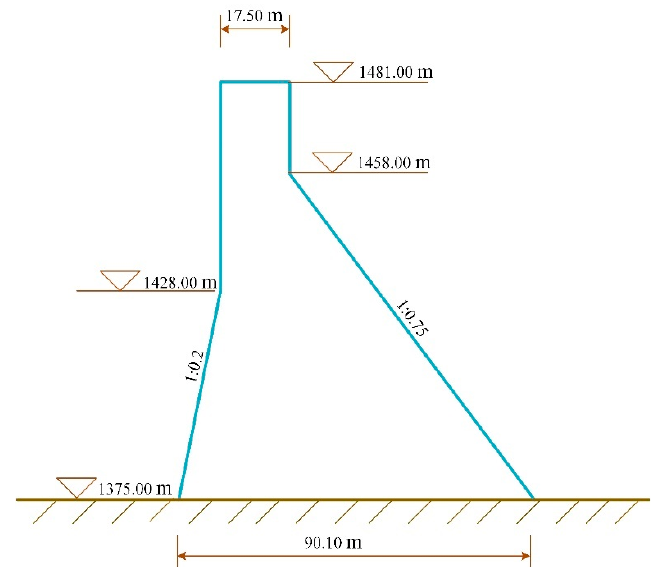
Figure 2. Typical profile of a gravity dam. Table 1. Statistical characteristic and value ranges of the considered factors.